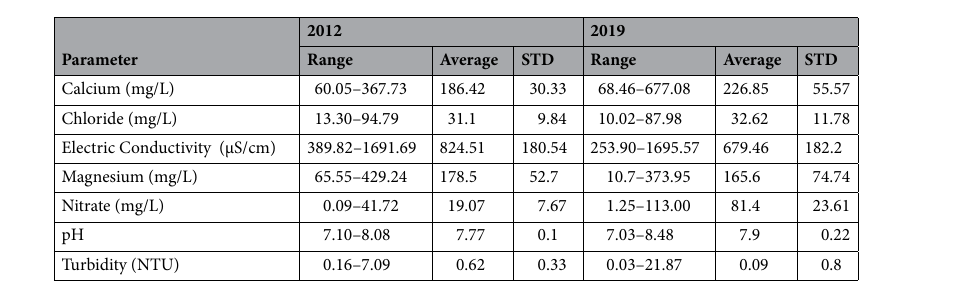
Table 2. Groundwater quality parameters. STD standard